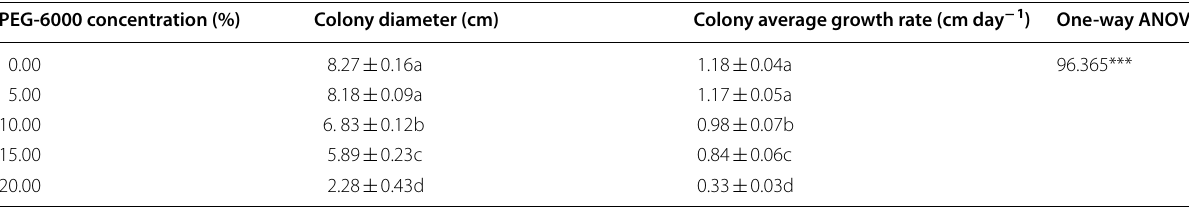
Table 3 Influence of PEG-6000-induced drought stress on mycelial growth of X. badius